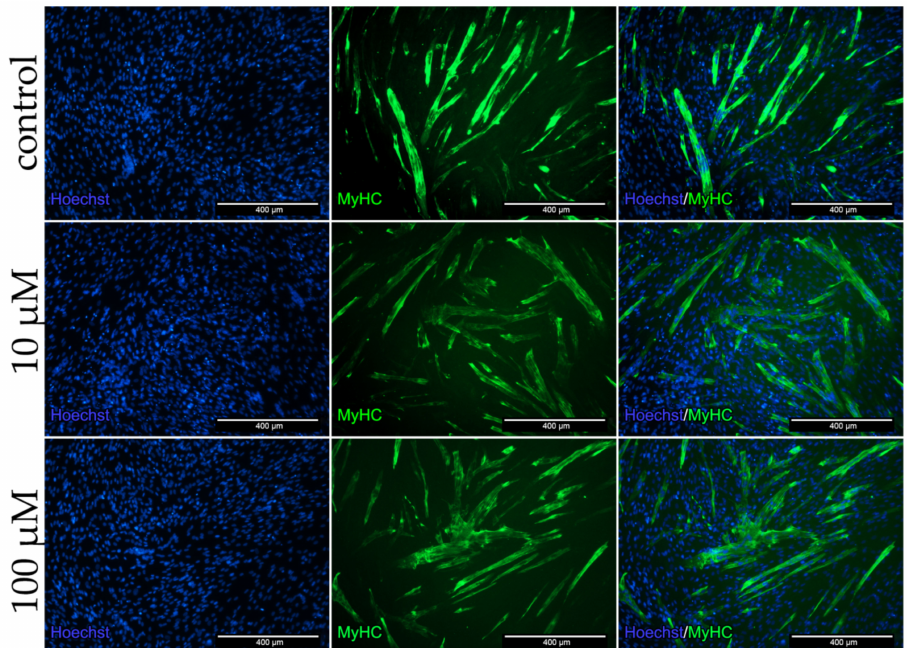
Figure 7. Immunofluorescence staining for MyHC after 96 h incubation in DM with 10 and 100 µ M dex in the co-culture and untreated control. Myotubes were stained with MyHC (MyHC, green) specific antibody. Nucleus staining was performed using Hoechst dye (blue).